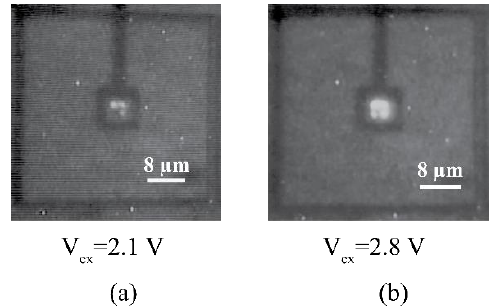
Figure 20. Light emission test to demonstrate reverse breakdown occurring at sharp corners at V ex = 2.1 V ( a ) and V ex = 2.8 V ( b ).